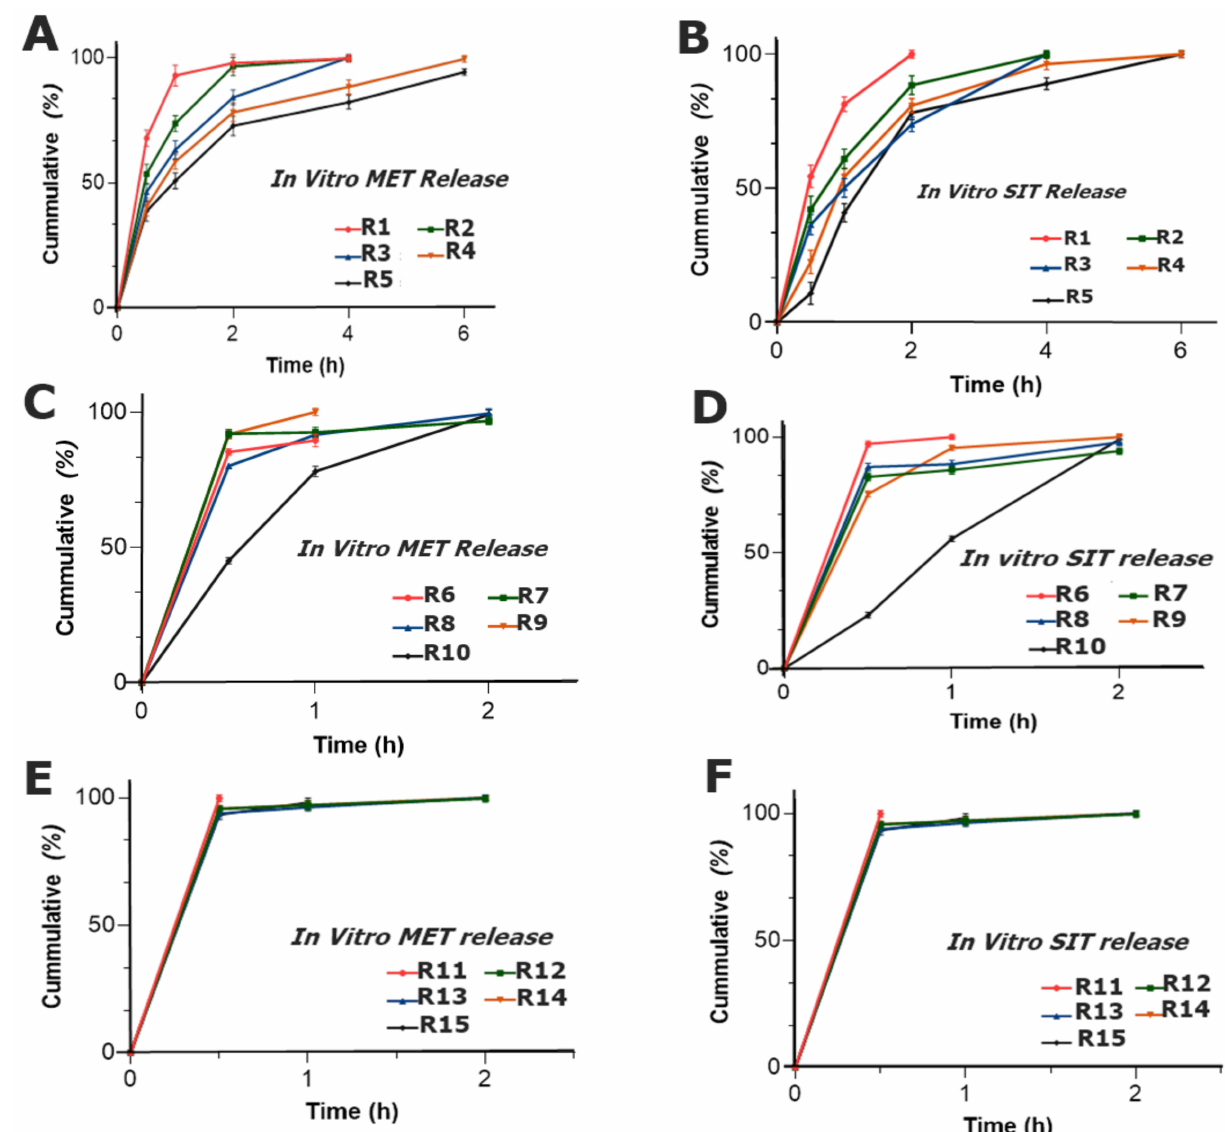
Figure 9. Cumulative release of ( A ) MET and ( B ) SIT of the formulations R1–R5; ( C ) MET and ( D ) SIT of the formulations R6–R10; and ( E ) MET and ( F ) SIT of the formulation